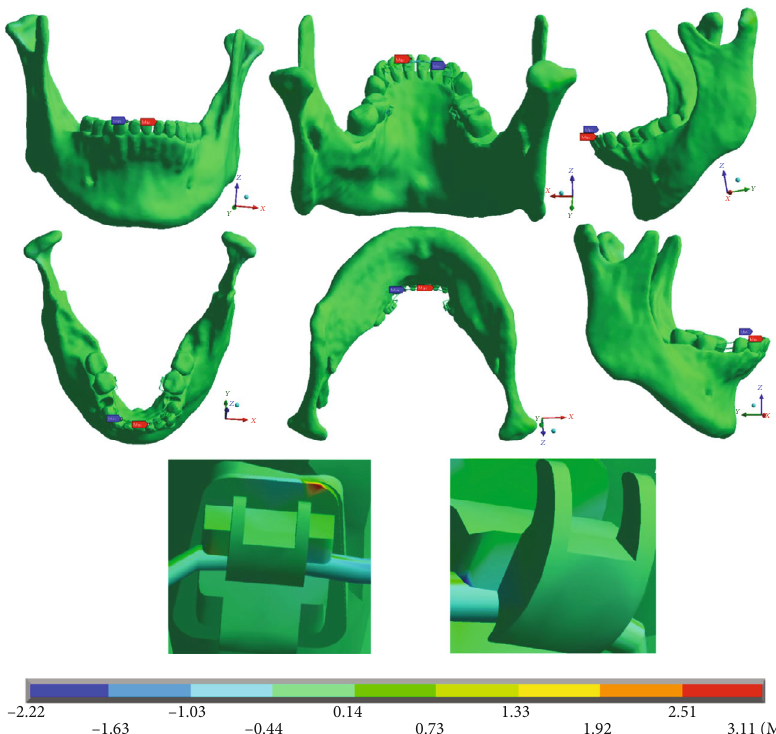
Figure 13: Normal stresses in the X complete system (mandibular bone, dental organs, brackets, and wires). The red marker indicates the maximum stresses, and the blue marker indicates the minor stresses.